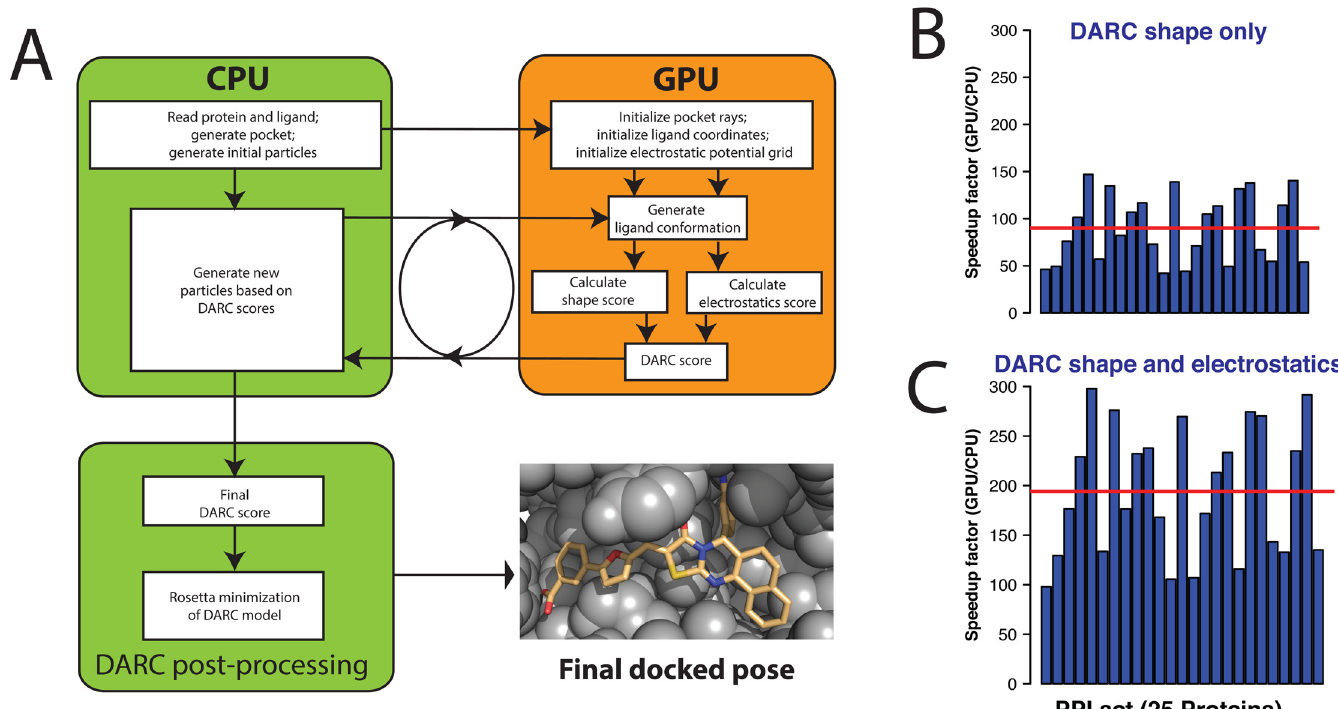
Fig 6. Updated GPU control flow. (A) Schematic illustration of CPU-GPU control flow in DARC 2.0. Previously, the ligand conformation was generated on the CPU and passed to the GPU; now, the conformer index / displacement / rotation (relative to a “ reference ” position) is instead passed, and the GPU is responsible for applying this transformation to the ligand ’ s atomic coordinates. The new electrostatic complementarity term is also computed entirely on the GPU. (B) For each protein-ligand complex in our set (S1 Table), we timed DARC when docking the ligand back into its cognate receptor, using either GPU +CPU or CPU alone. We find an average speedup of 90-fold when using the GPU (red line), an improvement over the 27-fold speedup we achieved in our original GPU implementation of DARC [26]. (C) The GPU led to an even greater speedup over the analogous calculation on the CPU when electrostatic complementarity was included in both calculations (190-fold